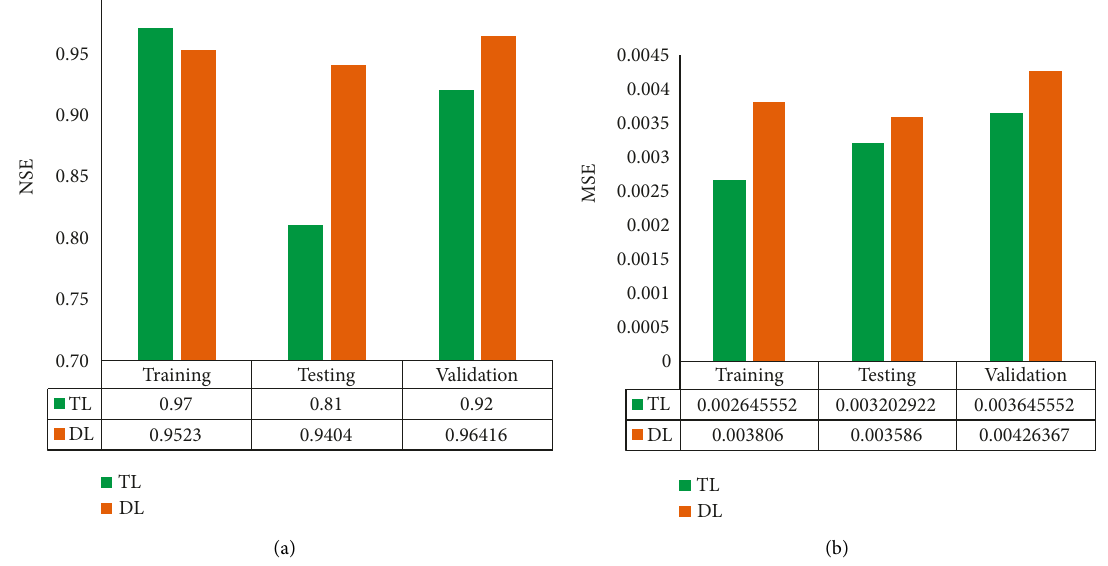
Figure 7: ANN1 results. (a) The values of NSE. (b) The values of